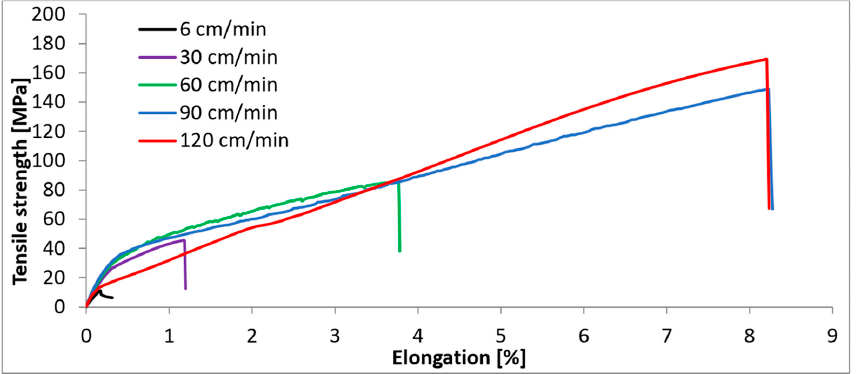
Figure 10. Tensile test curves registered to failure for specimens sintering at 600 °C temperature under different gas linear flows.